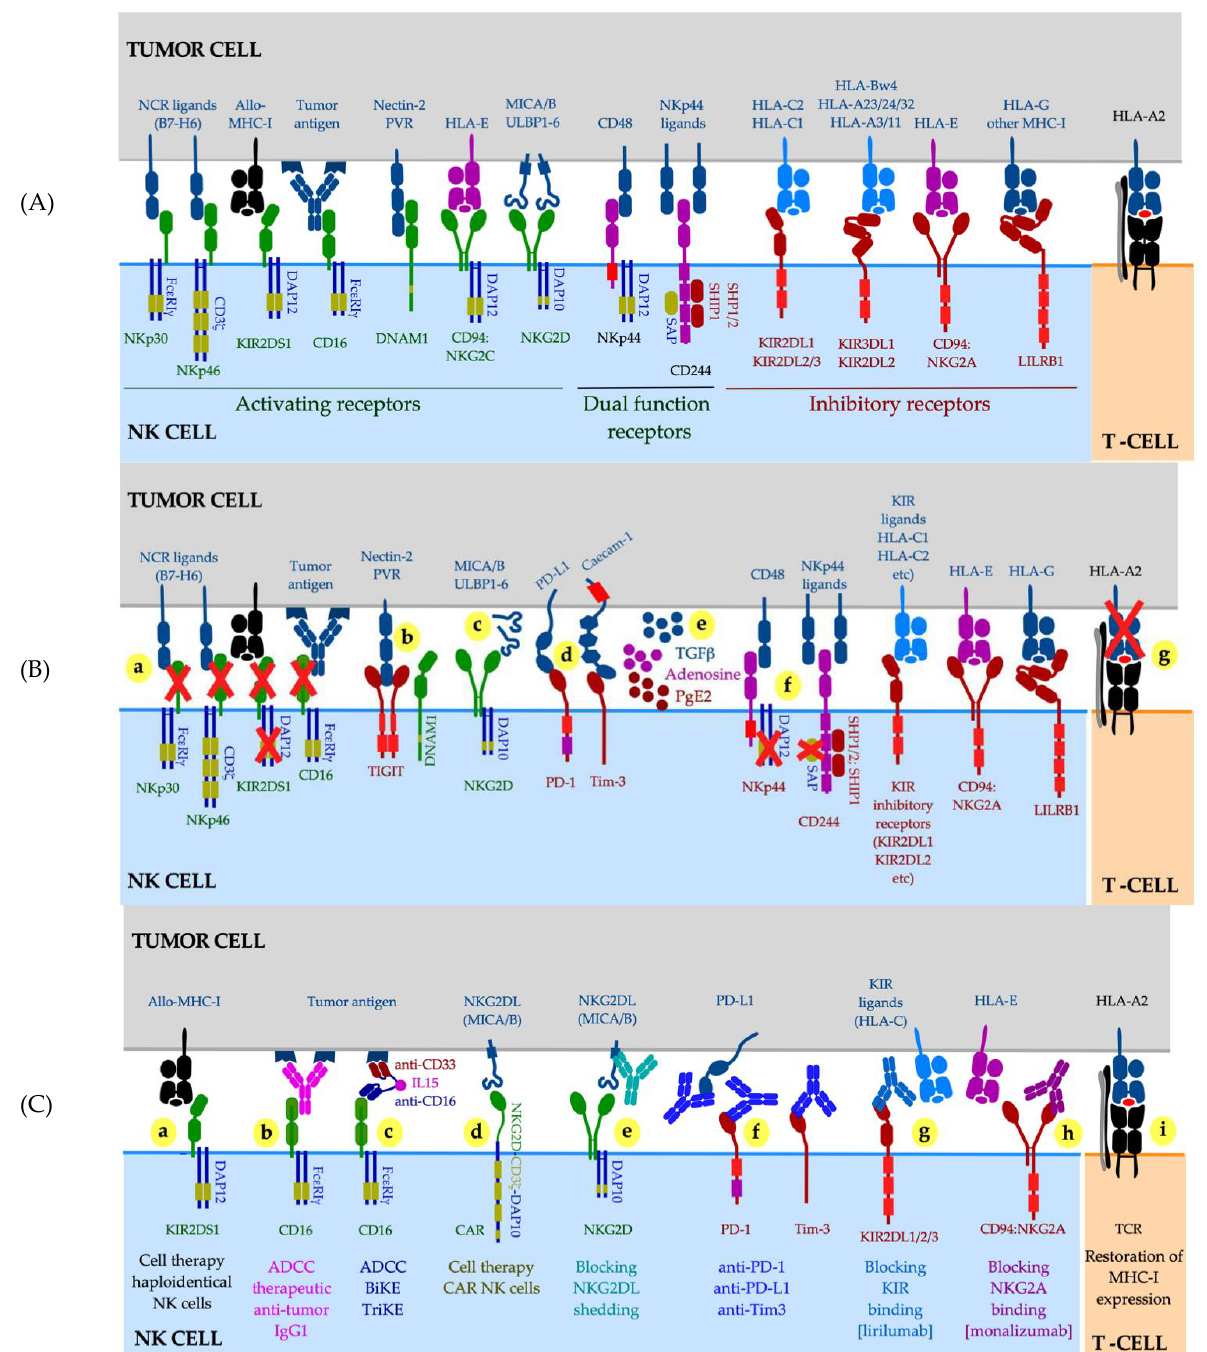
Figure 2. Alteration of NK cell functions in cancer and strategies to overcome it. ( A ) NK receptors and their principal ligands relevant to oncoimmunology. Activating receptors are shown in green, the associating signaling adaptors are shown in blue, with immunoreceptor tyrosine-based activation motifs (ITAMs) marked in olive. Inhibitory receptors with immunoreceptor tyrosine-based inhibition motifs (ITIM) are shown in red. Dual function receptors (purple) provide either activating or inhibitory input, via a combination of ITAMs or ITIMs (NKp44) or through immunoreceptor tyrosine-based switch motifs (ITSMs) that recruit both activating adaptors and phosphatases (CD244). ( B ) Mechanisms preventing efficient NK cell activation in cancer: downregulation of activating receptors and/or adaptors (a); engagement of DNAX accessory molecule (DNAM)1 ligands by the inhibitory competitor T-cell immunoglobulin and ITIM domain (TIGIT) (b); proteolytic shedding of NK group 2D (NKGD) ligands MHC-I chain-related proteins (MIC)A and MICB (c); expression of inhibitory checkpoints (d); production of inhibitory mediators adenosine, prostaglandin E2 and transforming growth factor beta (TGF β )